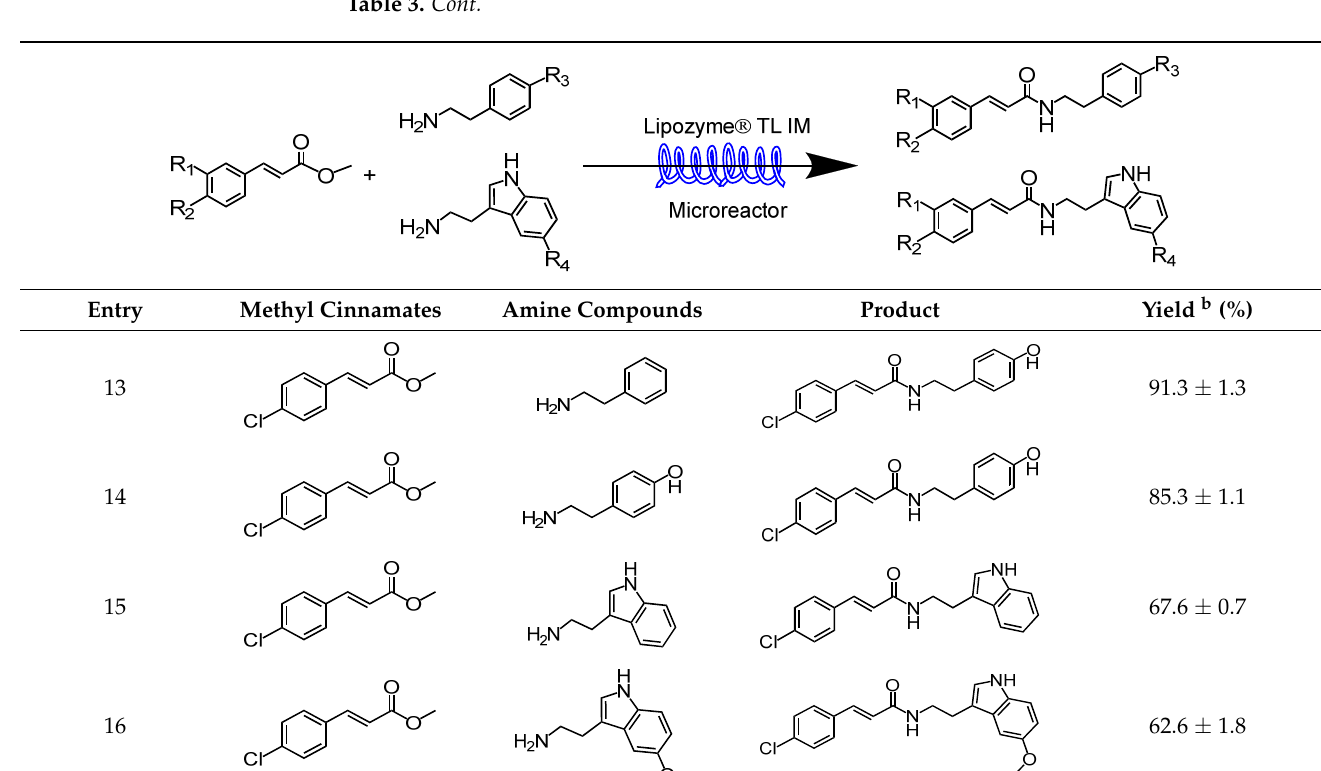
62.6 ± 1.8 a Reaction conditions: feed 1, 5.0 mmol methyl cinnamate derivative dissolved in 10 mL tert -amyl alcohol, feed 2, 10.0 mmol amine compounds dissolved in 10 mL tert -amyl alcohol, Lipozyme ® TL IM (catalyst reactivity: 250IUN·g − 1 ) 0.87 g, flow rate 15.6 μ L min − 1 , 40 min residence time at 45 °C. b Isolated yield. Yield: 100× (actual received quantity/ideal calculated quantity). The data are pre- sented as average ± SD of triplicate experiments.